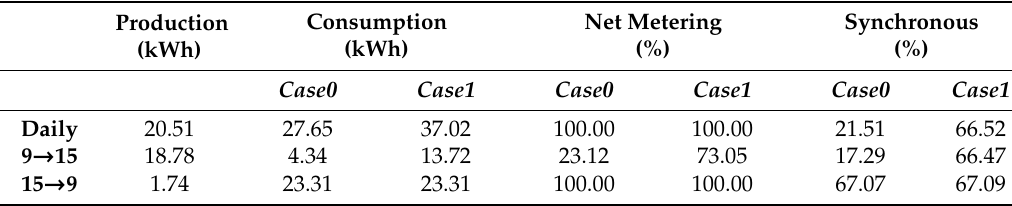
Table 2. Community production, consumption and